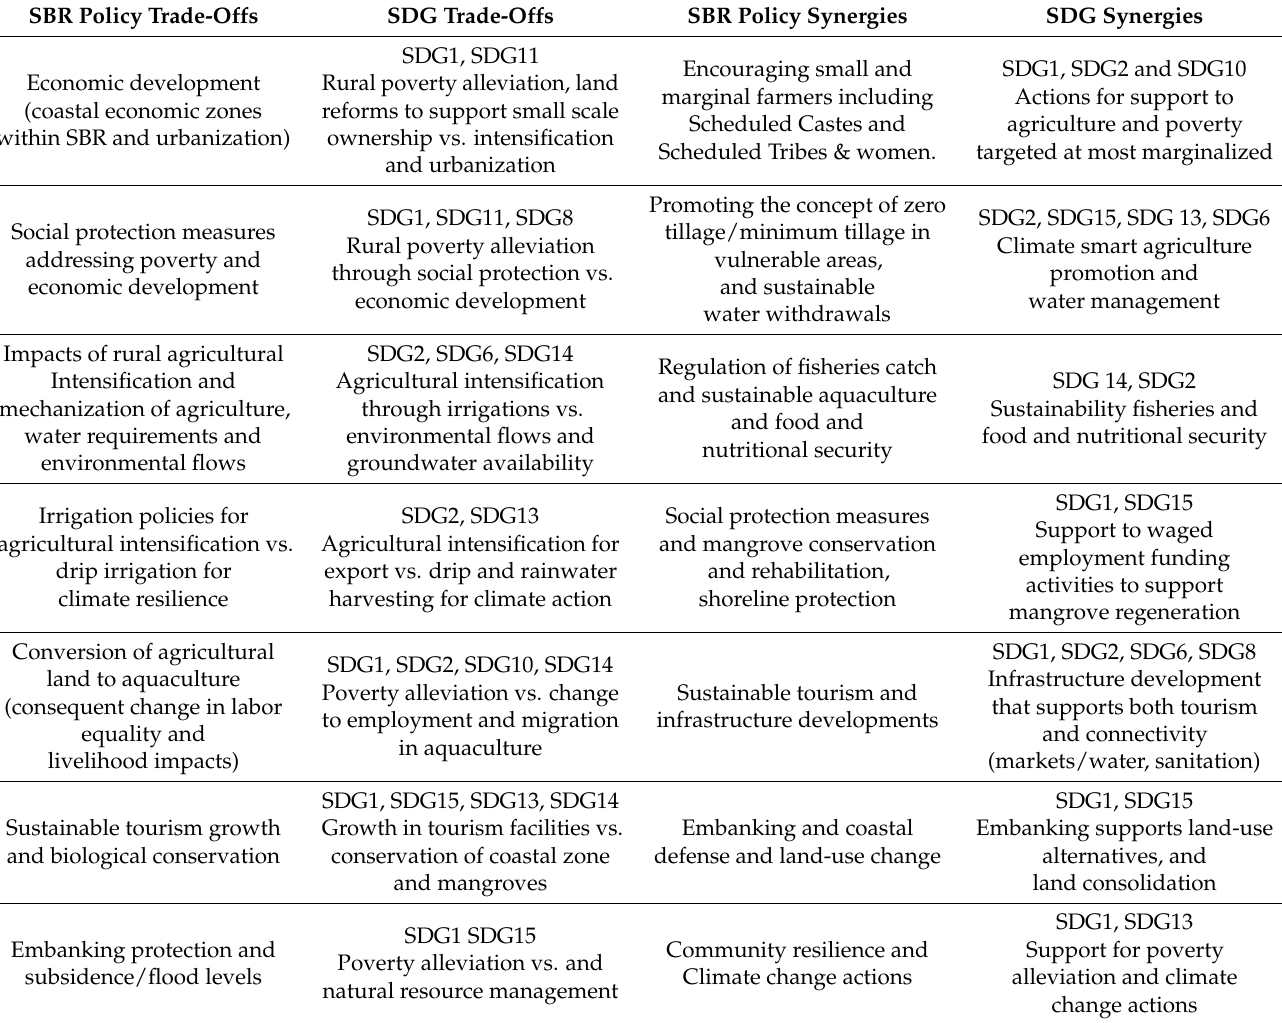
Table 1. Trade-offs ( − ve interactions) and synergies (+ve interactions) between policies and SDG targets in the SBR. SBR Policy